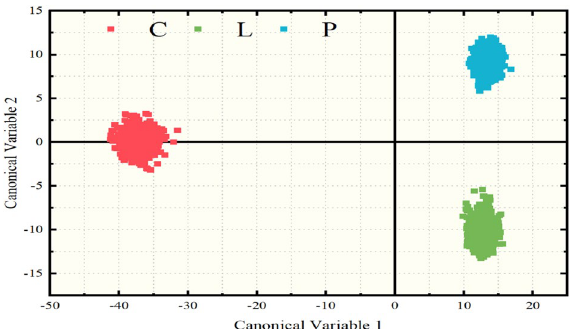
Figure 1. LDA canonical variables plot for the olive oil samples originating from different geographical regions. Red data points correspond to samples from Crete (C), green and blue data points correspond to samples from Lesvos (L) and Peloponnese (P) respectively.